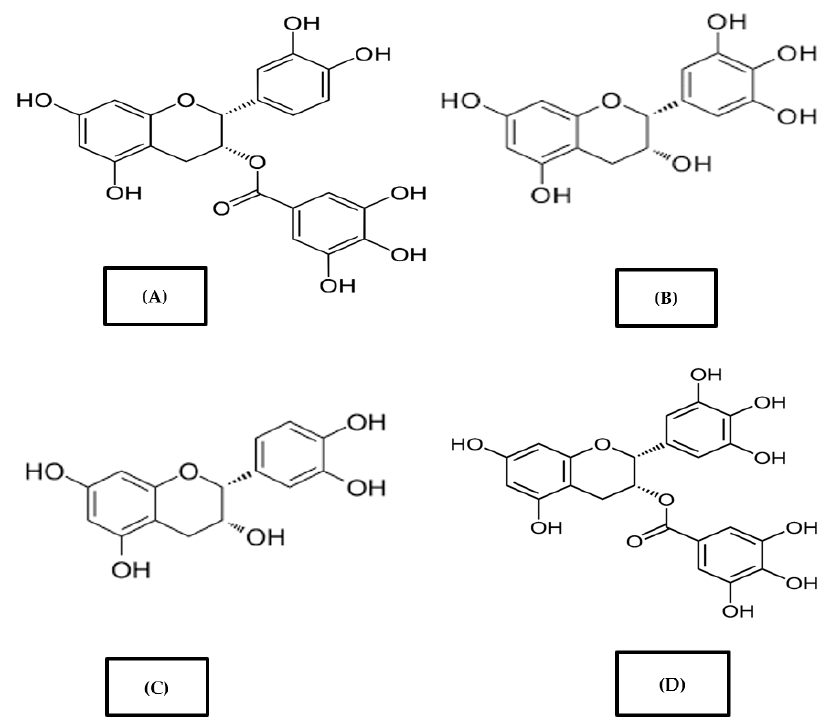
Figure 1. Chemical structures of major polyphenols present in green tea: ( A ) Epicatechin gallate, ( B ) Epigallocatechin, ( C ) Epicatechin, ( D ) Epigallocatechin gallate.